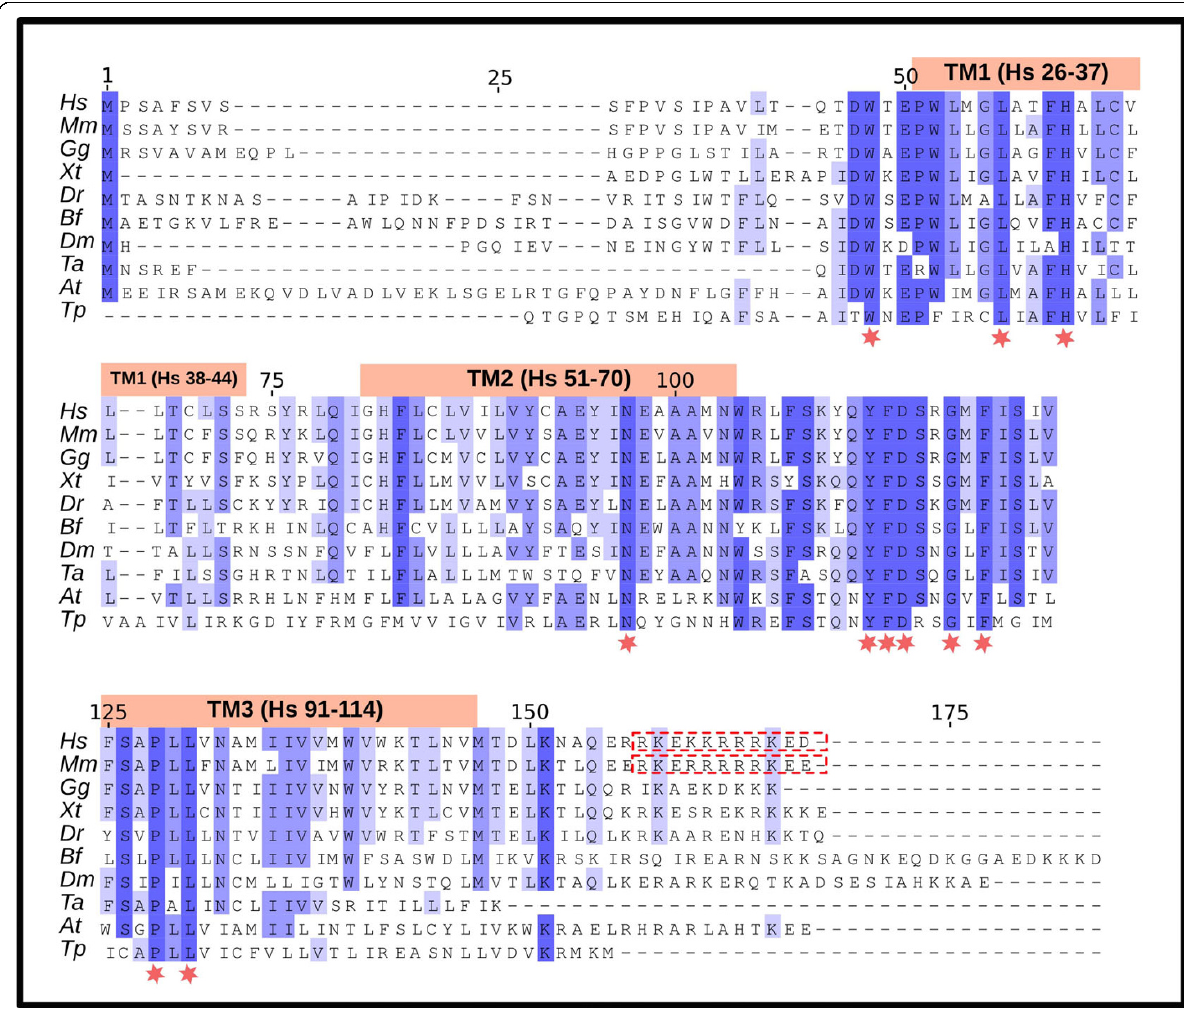
Figure 2 Multiple sequence alignment of the TMEM18 family . The protein sequences were aligned using mafft-einsi with the default parameters and viewed and edited with Jalview. The column color intensity corresponds to the degree of conservation and completely conserved residues are marked with a red star. The predicted transmembrane helices of the human TMEM18 protein are represented by pink boxes and the predicted nuclear localization signals for the mouse and human are marked with red boxes in the